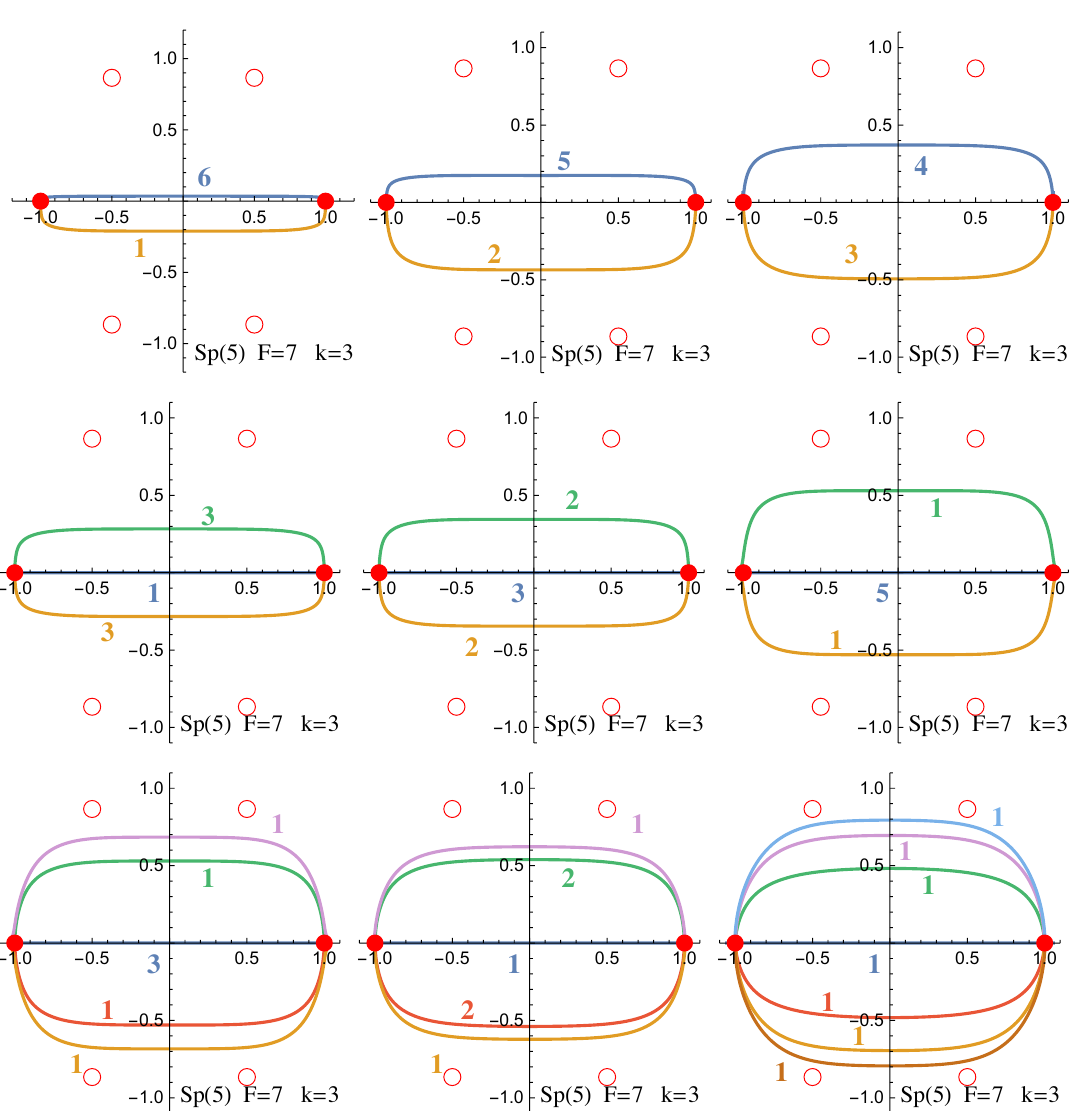
Figure 9 . Examples of domain walls in Sp(5) , F = 7 : here are listed the parameters of the deformations used to compute these solutions. First line from left to right, the (cid:15) − 0 . 1 , − 0 . 1 , − 0 . 1 , − 0 . 1 , − 0 . 1) , (0 . 1 , 0 . 1 , − 0 . 1 , − 0 . 1 , − 0 . 1 , − 0 . 1 , − 0 . 1) , (0 . 1 , 0 . 1 , 0 . 1 , − 0 . 1 , − 0 . 1 − 0 . 1 , − 0 . 1) . Second line from left to right, (0 , 0 . 1 , 0 . 1 , 0 . 1 , 0 . 1 , 0 . 1 , 0 . 1) , (0 , 0 , 0 , 0 . 1 , 0 . 1 , 0 . 1 , 0 . 1) , ( − 0 . 1 , − 0 . 1 , − 0 . 1 , − 0 . 1 , − 0 . 1 , 0 . 1 , 0 . 1) . Third line from left to right (0 . 1 , 0 . 1 , 0 . 2 , 0 . 2 , − 0 . 1 , − 0 . 1 , − 0 . 1) , (0 . 05 , 0 . 05 , 0 . 05 , 0 . 05 , − 0 . 1 , 0 . 1 , 0 . 1) , (0 . 05 , 0 . 05 , 0 . 2 , 0 . 2 , 0 . 3 , 0 . 3 , − 0 . 1)